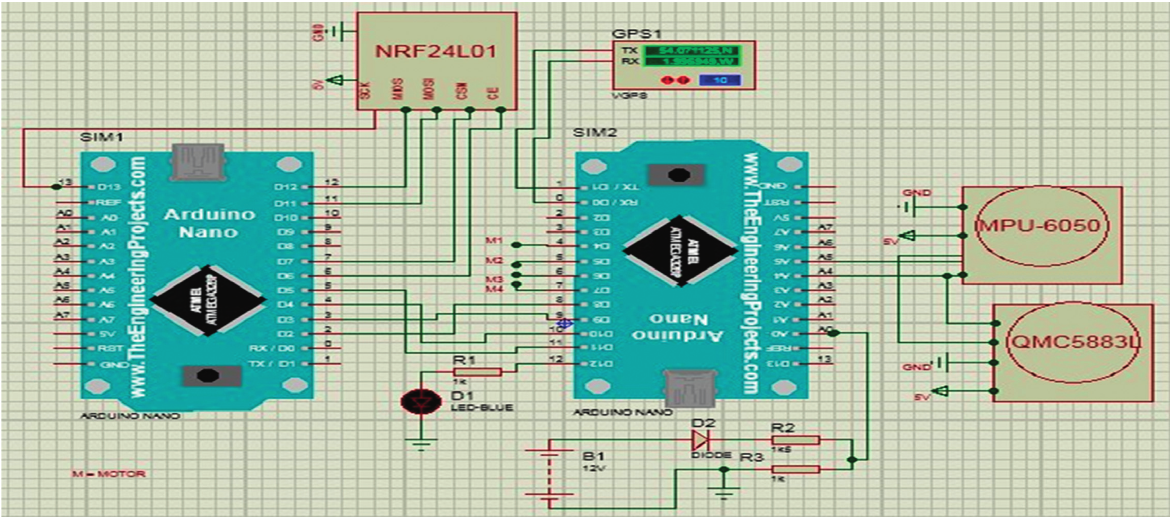
Figure 8: The connection with the microcontroller.